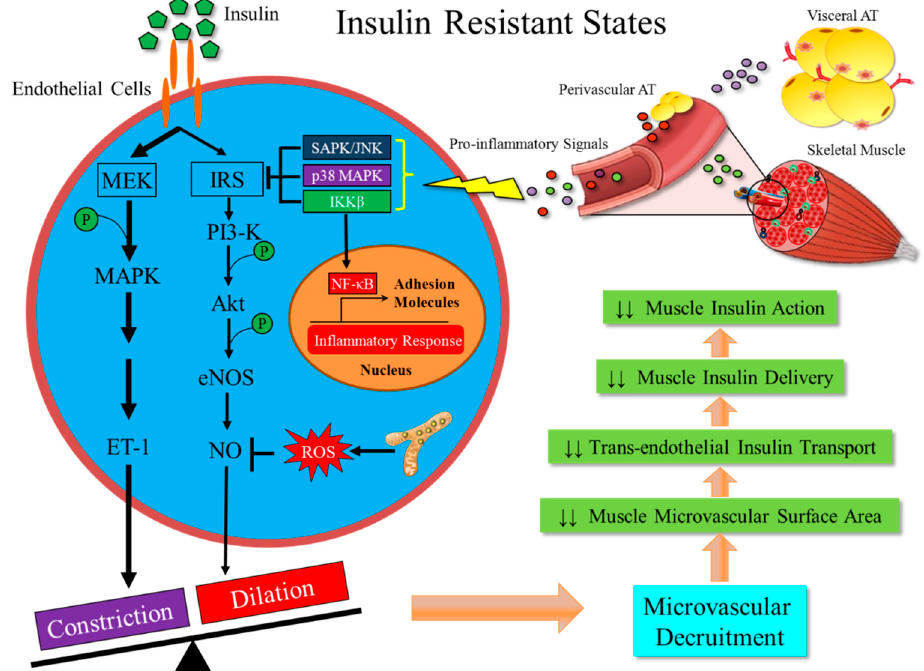
Figure 2. Inflammation in the muscle microvasculature reduces insulin-mediated microvascular recruitment and trans-endothelial insulin transport. In the insulin resistant states, multiple pro-inflammatory factors contribute to the development of inflammation in the muscle microvasculature through a combination of endocrine, paracrine and autocrine actions. Inflammation results in a pathway selective insulin resistance, leading to lower NO bioavailability, less microvascular recruitment and reduced trans-endothelial insulin transport. (Abbreviations: FFAs, free fatty acids; AT, adipose tissue; PVAT, perivascular adipose tissue; NF- κ B, nuclear factor kappa-light-chain-enhancer of activated B cells; JNK, c-jun N-terminal kinase). Colored circles are pro-inflammatory factors from various sources.